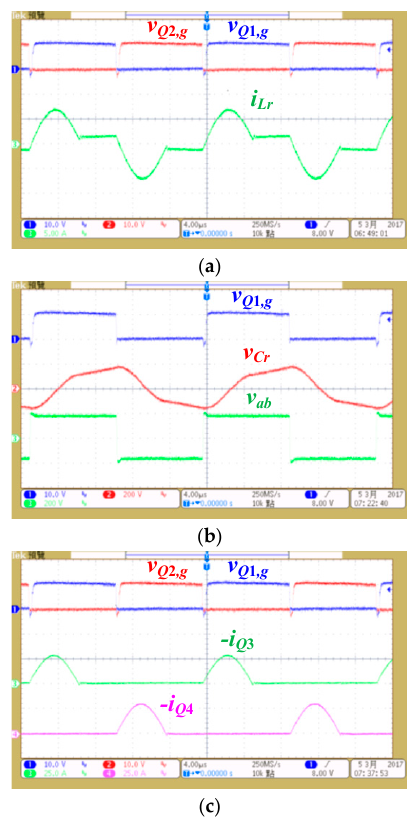
Figure 7. Test results under forward power transfer and full load with V H = 350 V ( a ) v Q 1 ,g , v Q 2 ,g and i Lr [ v Q 1 ,g , v Q 2 ,g : 10 V/div; i Lr : 5 A/div; time: 4 µ s/div] ( b ) v Q 1 ,g , v Cr and v ab [ v Q 1 ,g : 10 V/div; v Cr , v ab : 200 V/div; time: 4 µ s/div] ( c ) v Q 1 ,g , v Q 2 ,g , − i Q 3 and − i Q 4 [ v Q 1 ,g , v Q 2 ,g : 10V/div; − i Q 3 , − i Q 4 ,g : 25 A/div; time: 4 µ